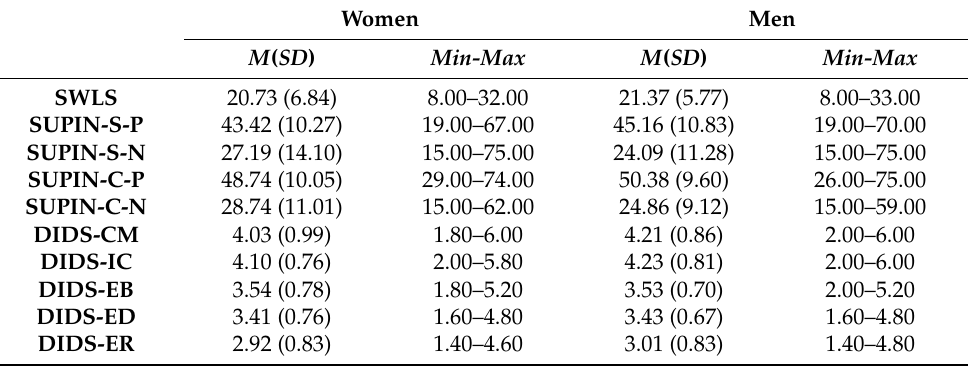
Table 2. Descriptive